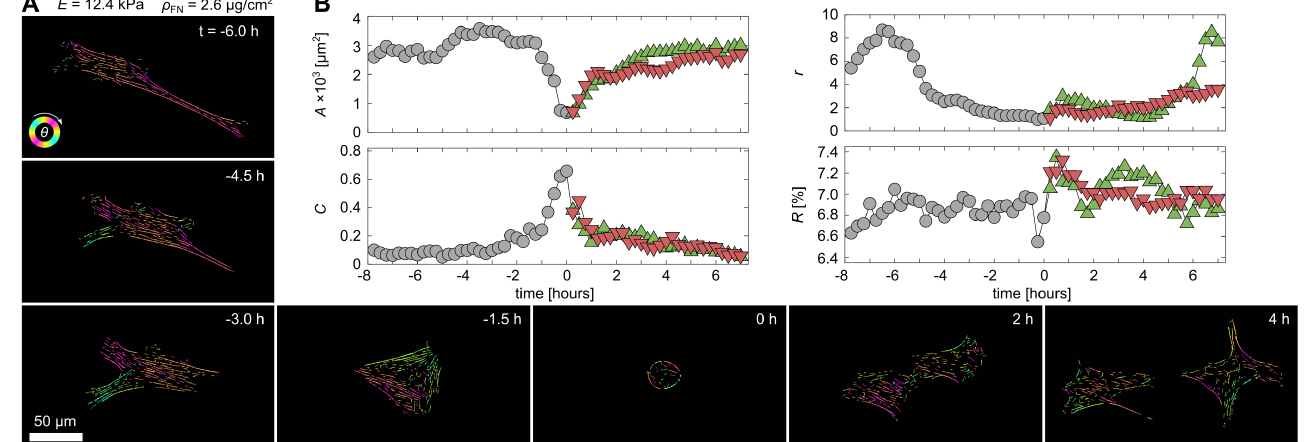
Figure 6. Proliferation dynamic of a single myocyte on a rigid hydrogel. ( A ) Snapshots of a C2C12 muscle cell that undergoes proliferation at about t = 0 min on a E (cid:39) 12.4 kPa hydrogel coated with ρ FN (cid:39) 2.6 µ g/cm 2 . The images were processed by AQuA. ( B ) Temporal tracking of the projected cell area A , the circularity C , aspect ratio r and fraction of actin amount to cell area R during 15 h of cell migration and proliferation. The mother and two daughter cells are distinguished by gray circles, green upward- and red downward-pointing triangles,